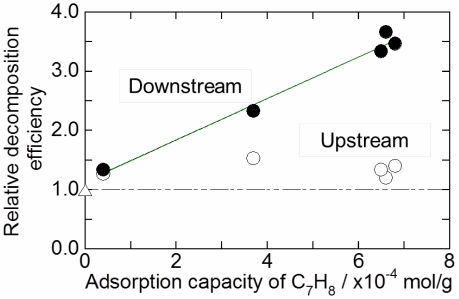
Figure 1. Relationship between the decomposition efficiency and adsorption capacity for